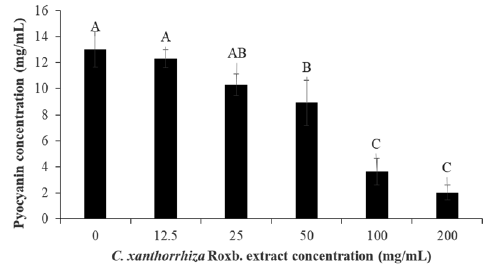
Fig. 3. Pyocyanin inhibition by the Curcuma xanthorrhiza Roxb. extract concentration (0-200 mg/mL). The pyoycanin concentration (mg/mL) after treated with Curcuma xanthorrhiza Roxb. extract concentration (0- 200 mg/mL). The alphabetical grouping represent the significance different between extract concentration (Those that share similar letter is not significant